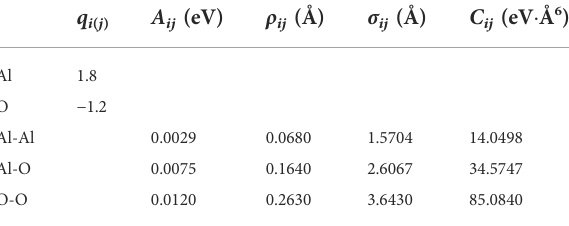
TABLE 1 Parameters for the alumina potentials taken from Bouhadja and Jakse (2019) study.